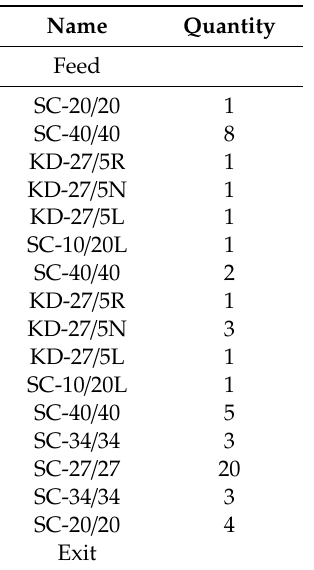
Table A1. Screw configuration beginning from the feed port 1